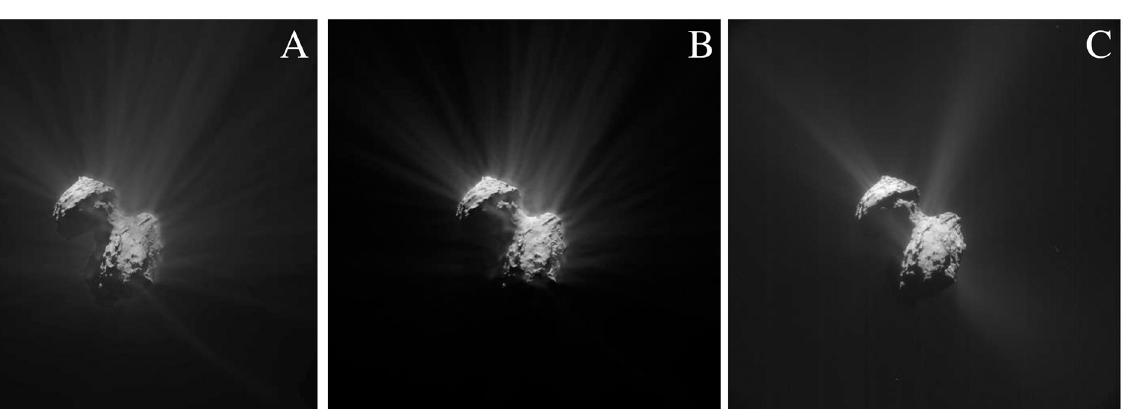
PLOS ONE | https://doi.org/10.1371/journal.pone.0263882 March 4,